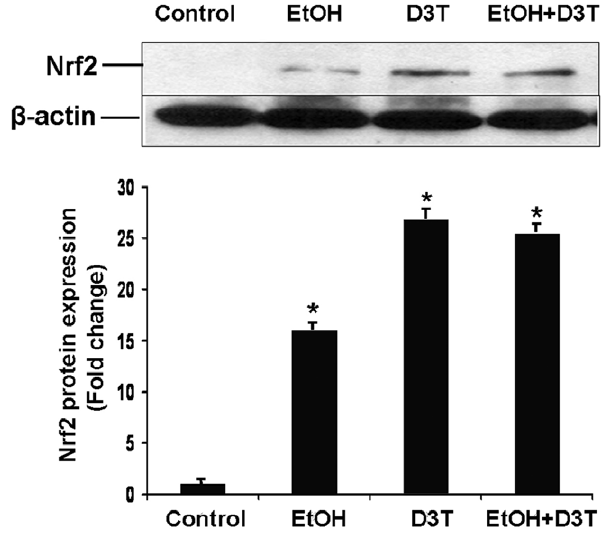
Figure 1. Treatment with ethanol and D3T increased the level of Nrf2 protein in PC12 cells. Western blot was performed to analyze the level of Nrf2 protein in PC12 cells. Cell lysates were prepared from PC12 cells cultured in control medium (Control), treated with 200 mM ethanol (EtOH), treated with 50 m M D3T alone (D3T), or treated with both ethanol and D3T (EtOH + D3T). Data are expressed as fold change over control and represent the mean 6 SEM of three separate experiments. * p , 0.05 vs.